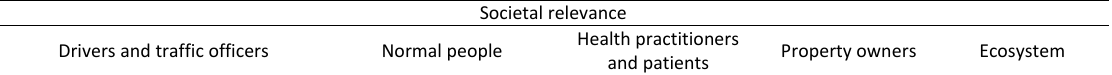
Table 2. Noise model stakeholders are categorized based on societal relevance.